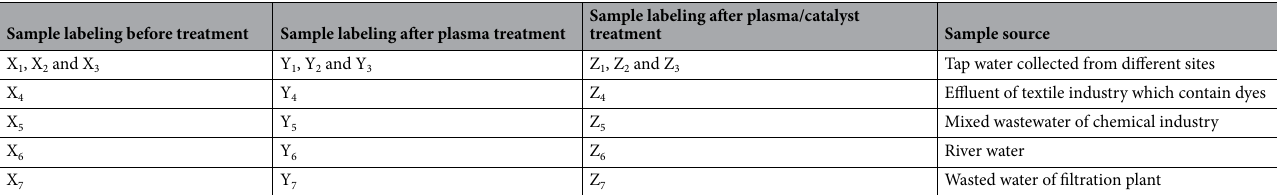
Table 2. Labeling of untreated, plasma treated and plasma/catalyst treated water samples.